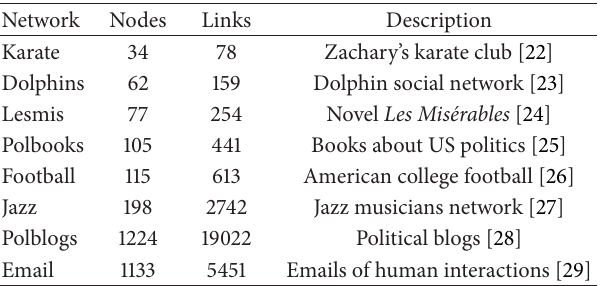
Table 1: Datasets of real-world